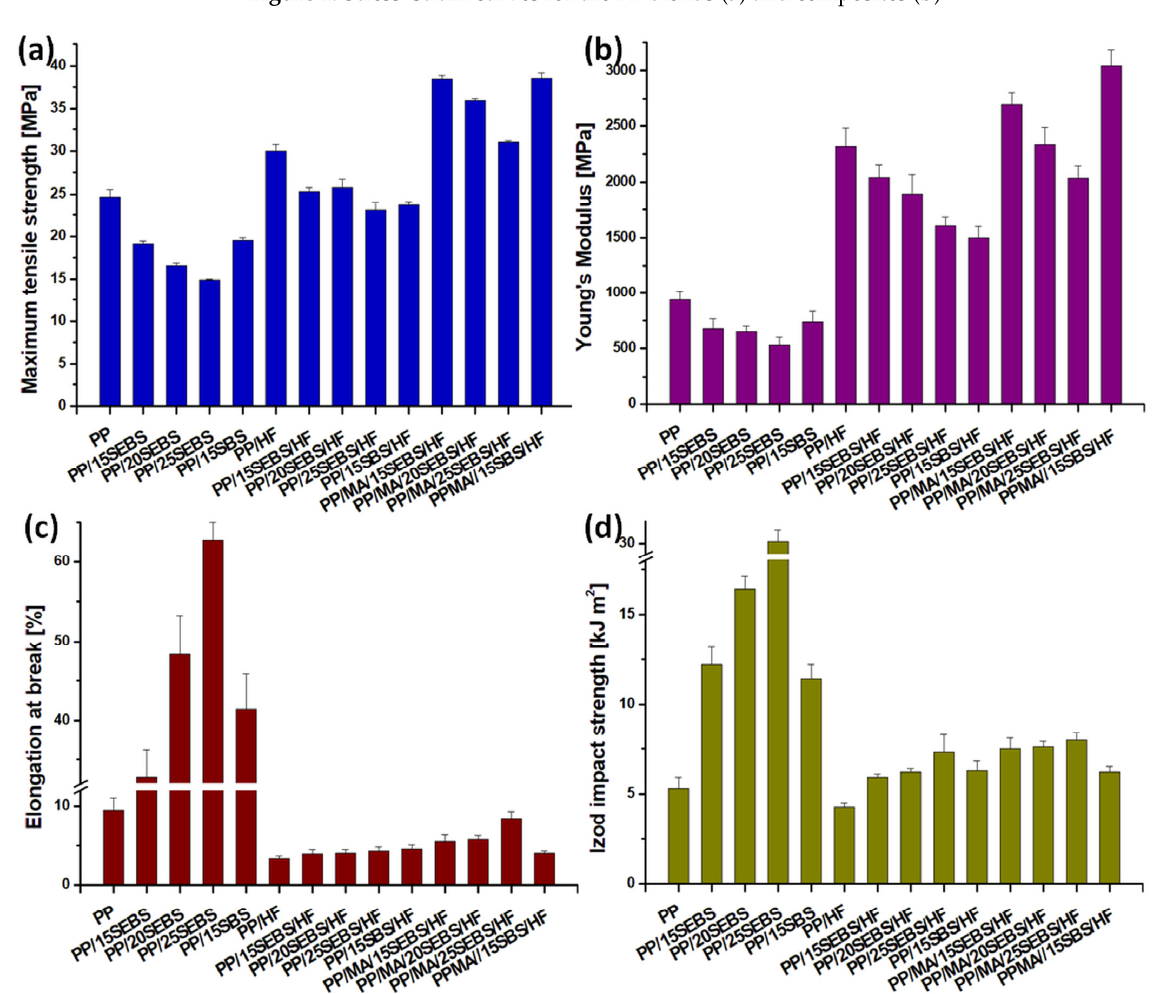
Figure 2. Tensile strength ( a ), Young’s modulus ( b ), elongation at break ( c ), and Izod impact strength ( d ) for the PP blends and composites. ( d ) for the PP blends and